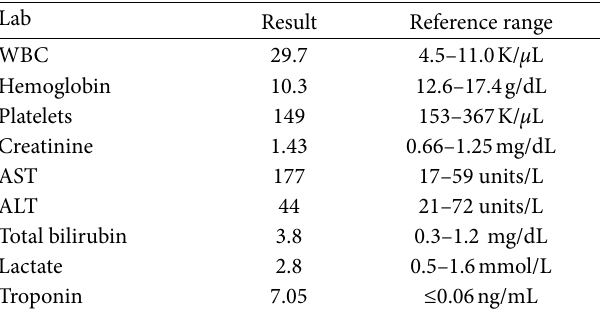
Table 1: Admission laboratory